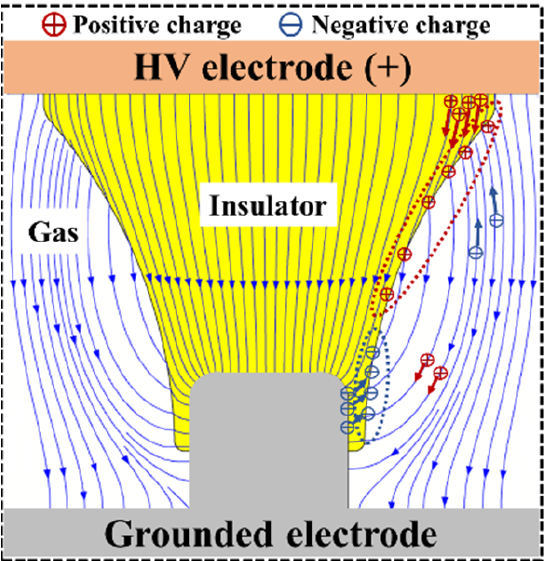
Figure 6. Surface charge accumulation process of tri–post epoxy insulator in clean state. charge spot. The electric field lines in the bottom region of the legs are oriented to the insulator, so the positive ions migrate to the surface of the insulator and form a positive charge spot. Compared with other positions, when the metal particle is attached at B in the middle of the leg, the electric field lines near the particles all pass through the surface of the insulator. The charged ions generated by corona discharge are more inclined to migrate to the surface of the insulator along the electric field lines, so the distribution of the charge spot is wider. Similarly, when metal dust is adsorbed on the surface of the tri-post epoxy insulator, the partial discharge between the dust particles can also generate charged ions, resulting in an increase in the gas conduction current and the accumulation of charge spots on the surface of the insulator. Due to the low intensity of partial discharge caused by metal dust, the charged ions generated by the discharge are mainly deposited on the insulating surface near the dust. Therefore, only negative charge spots are accumulated on the tri-post epoxy insulator leg attached to the metal dust.